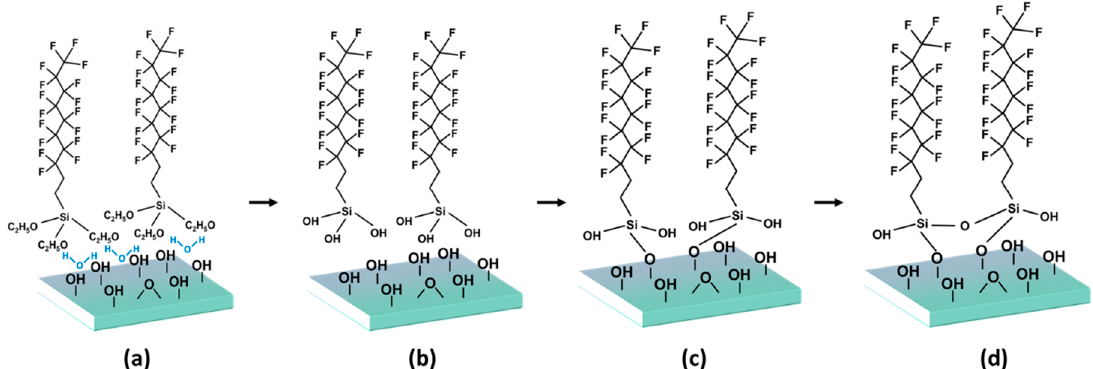
Figure 2. SAM formation of process. SAM is formed through ( a ) physisorption, ( b ) hydrolysis, ( c ) covalent grafting to the substrate, and ( d ) in plane reticulation.